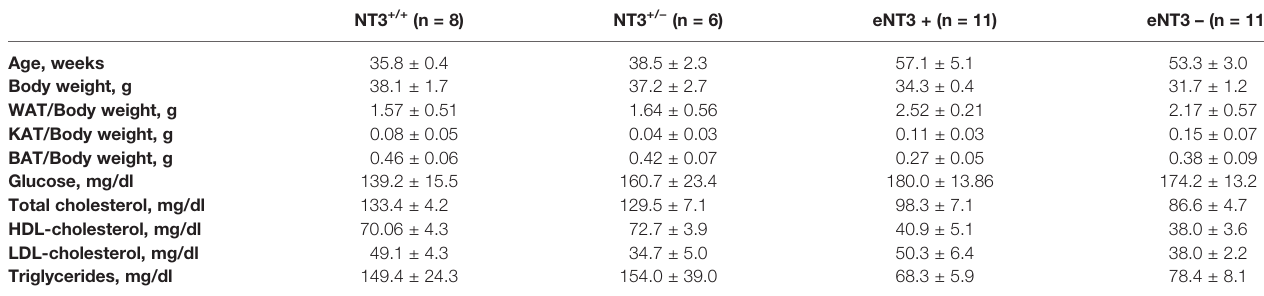
TABLE 2 | Analysis of body weight, fat depots and plasma biochemical markers in genetically engineered mice with de fi cient expression of NT3: Ntf3 +/lacZneo mice (NT3 +/ − ) and their littermates (NT3 +/+ ) and mice without endothelial expression of NT3 ( Ntf3 fl ox1/ fl ox2 ; Tie2-Cre +/0 : eNT3 - ) and their littermates (eNT3+).